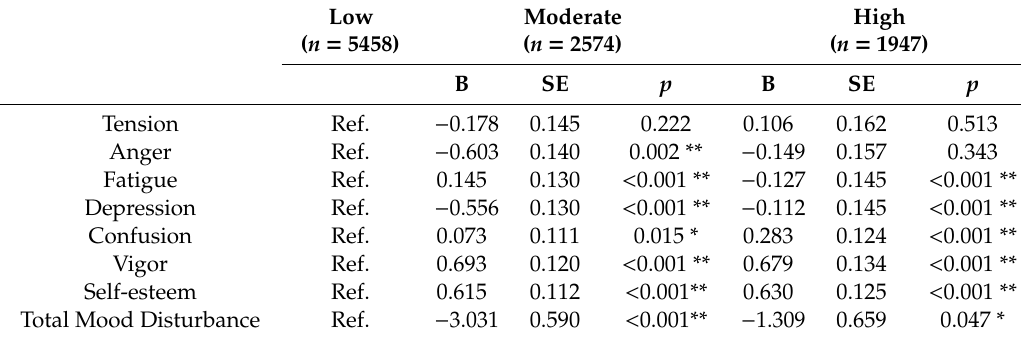
Table 4. The relationship between physical activity levels and mood